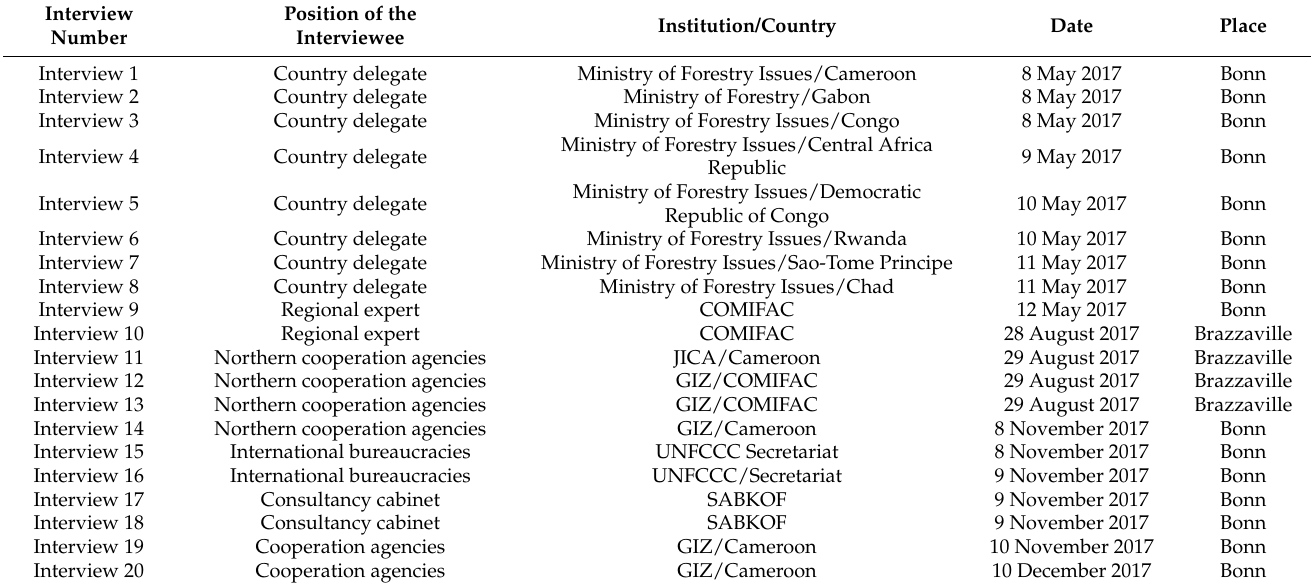
Table A1. List of